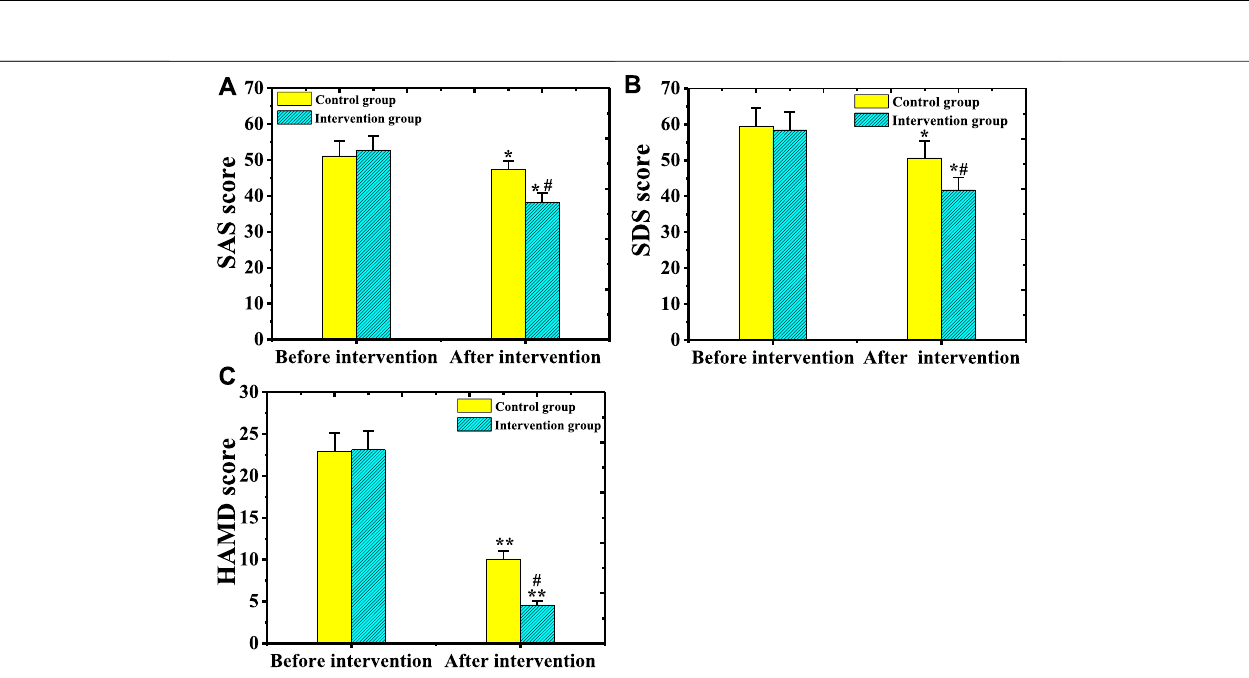
FIGURE 13 | Comparison on SDS, SAS, and HAMD scale scores between the two groups of patients before and after psychological intervention.[Note: (A) : Comparison ofSAS scale scores before and after psychological intervention between the two groups ofpatients; (B) : Comparison ofSDS scale scoresbefore and after psychological intervention between the two groups of patients; (C) : Comparison of HAMD scale scores before and after psychological intervention between the two groups of patients; * indicated p < 0.05 compared with before the intervention; ** meant p < 0.01 compared with before the intervention; # showed p < 0.05 compared with the control